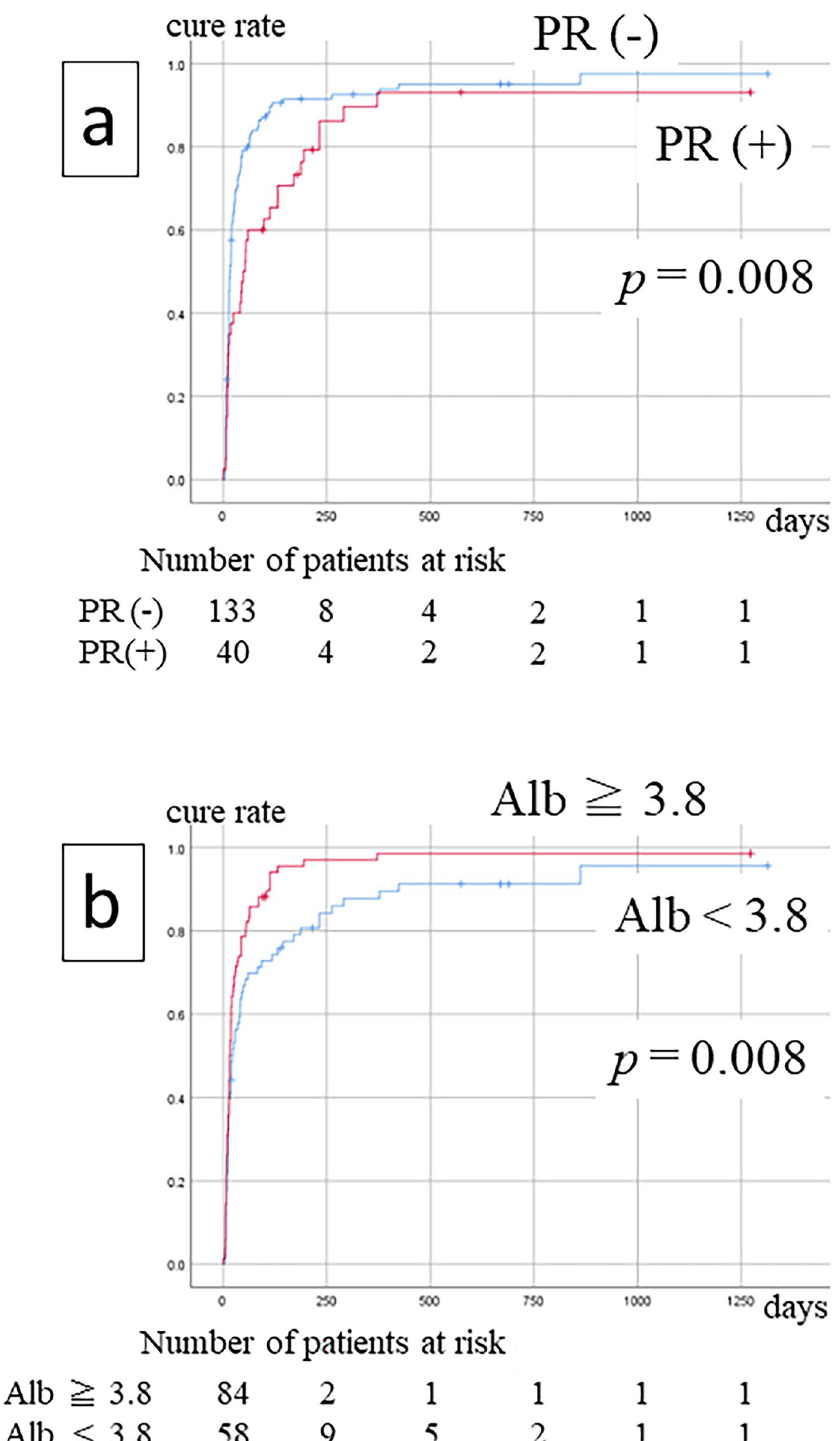
Figure 1. Factors related to the treatment outcomes of patients with medication-related osteonecrosis of the jaw. Patients with PR(+) showed significantly worse treatment outcomes than those with PR(−) ( a ). Patients with MRONJ cure rates in the Alb level ( b ). PR: periosteal reaction; Alb: serum